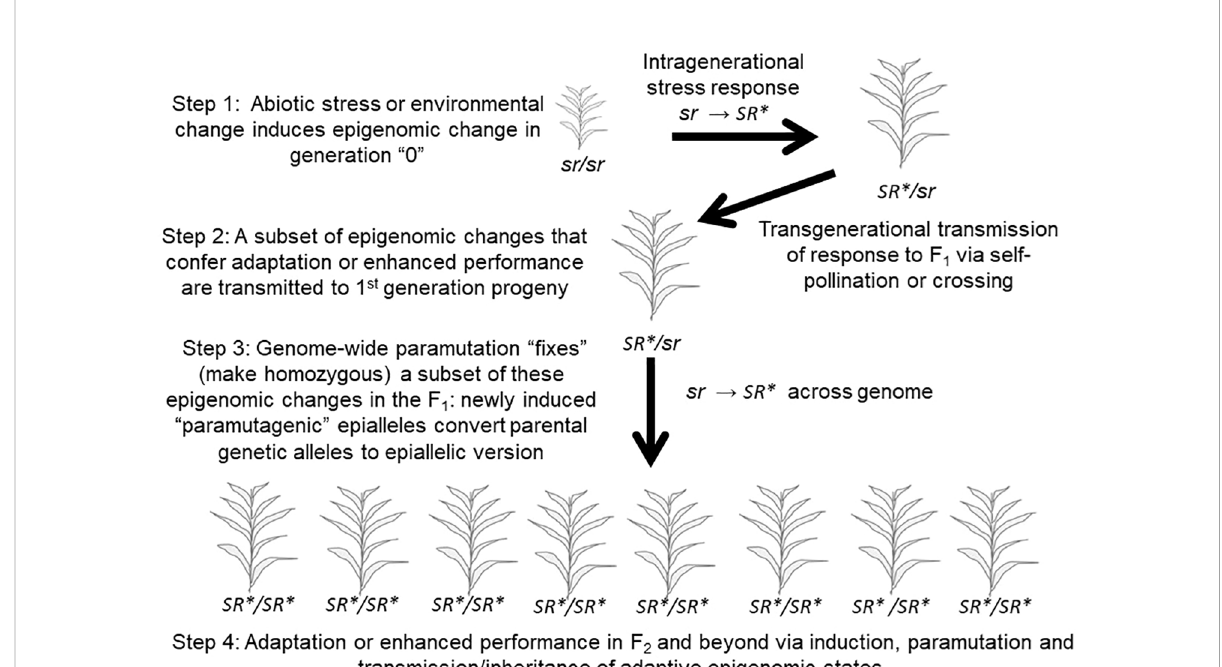
FIGURE 5 A Pseudo-Lamarckian Process that combines transgenerational adaptation to stress combined with paramutation. This process may rapidly fi x (make homozygous in all progeny) a stress-induced, adaptive epigenomic change. “ sr ” : the epigenomic state of an individual prior to a given stress. “ SR* ” : the epigenomic state of an individual following response to a given